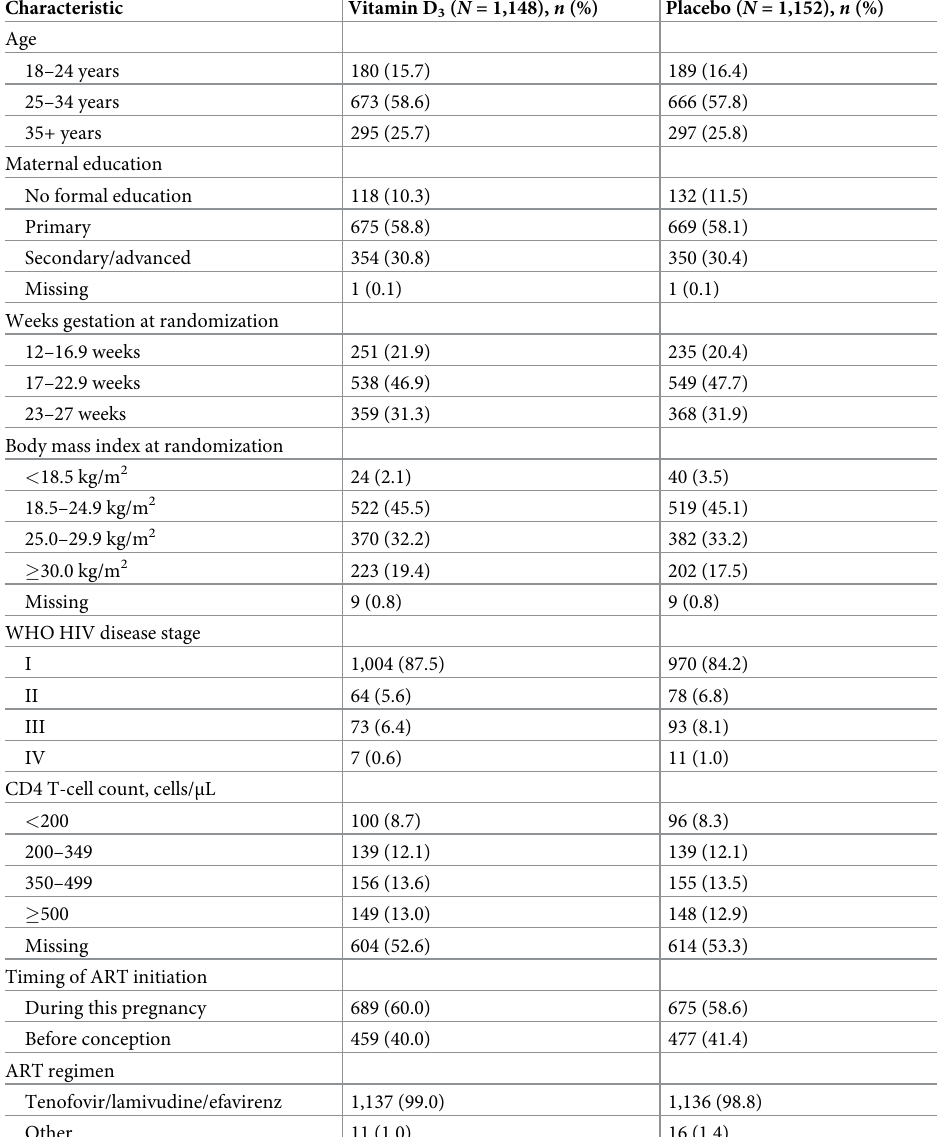
Table 1. Baseline characteristics of trial population of pregnant women living with HIV stratified by randomiza- tion group. Characteristic Vitamin D 3 ( N = 1,148), n (%) Placebo ( N = 1,152), n (%)